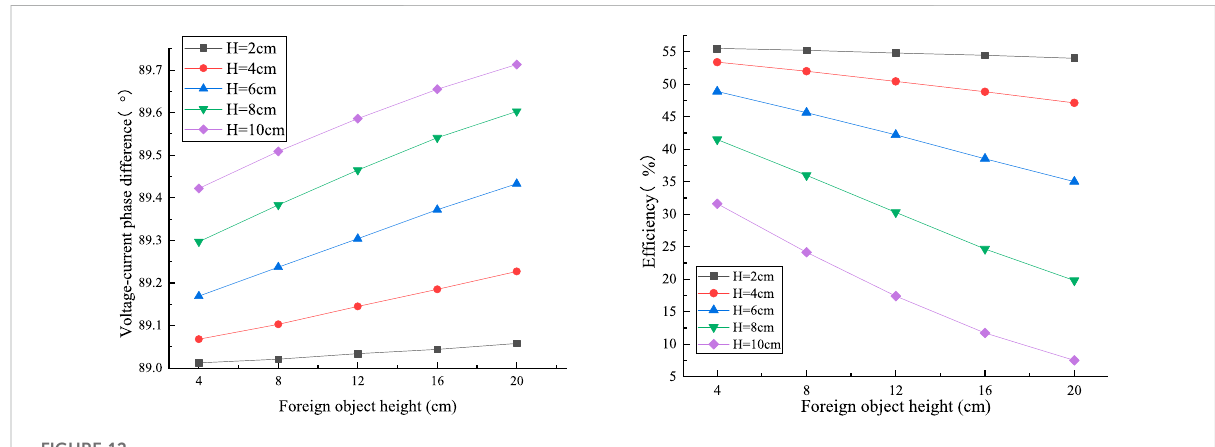
FIGURE 12 In fl uence of the changes in foreign object height on performance.